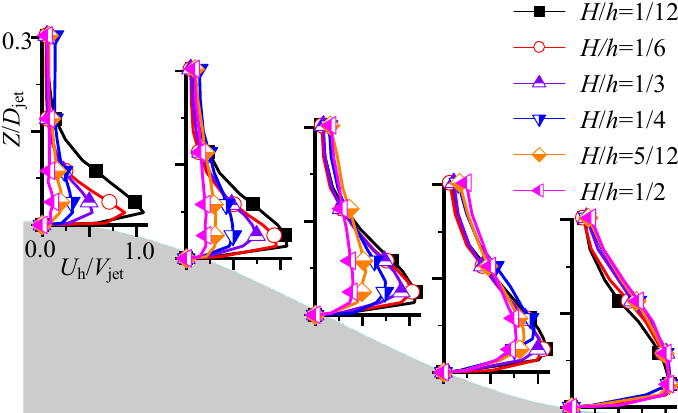
Figure 8. Profiles of horizontal wind velocity on y -axis ridge ( L = 0.5 D jet , r h = 1.0 D jet ).